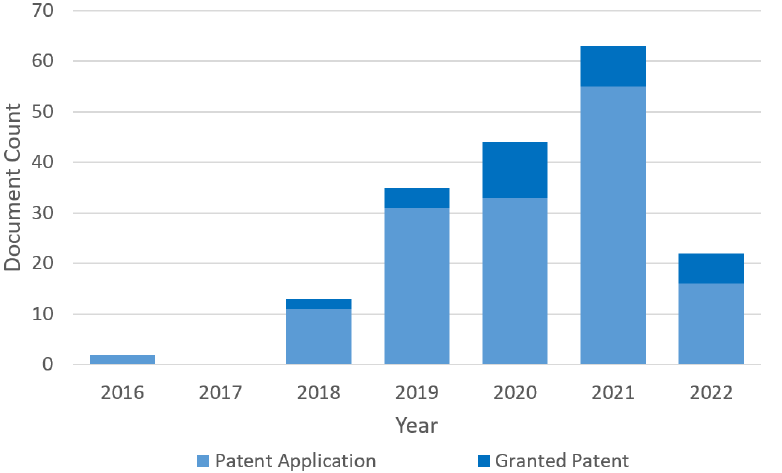
Figure 3. Number of patents in recent years. Patents were searched for on the Lens database; the keywords were “edge computing” and “software sensor”. In addition, there is a significant increase in their annual breakdown, which shows the relevance of the topic today. (Accessed the data at lens.org on 31 March